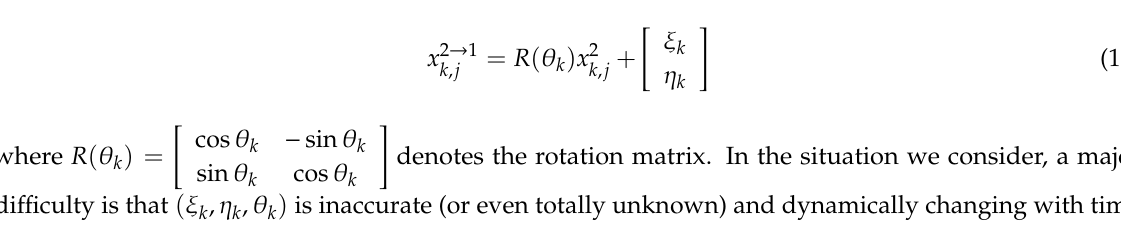
Figure 2. Relative translation and orientation between vehicle S1 and vehicle S2.